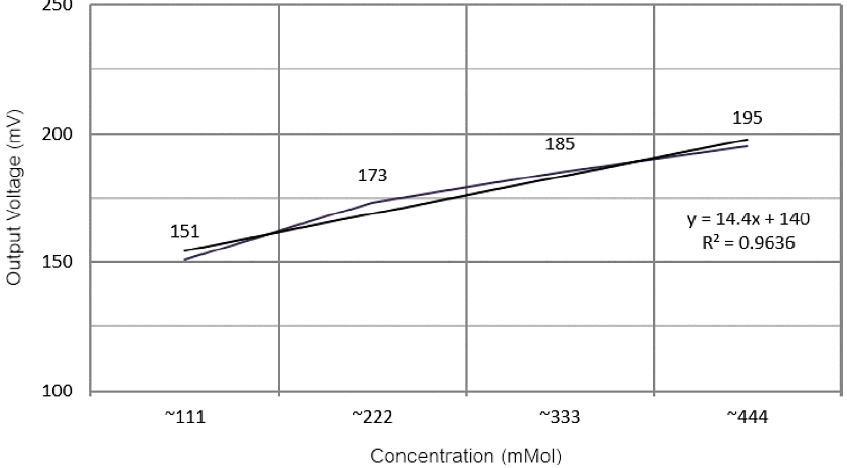
Figure 7. Experimental results for different glucose aqueous solution concentrations [33].